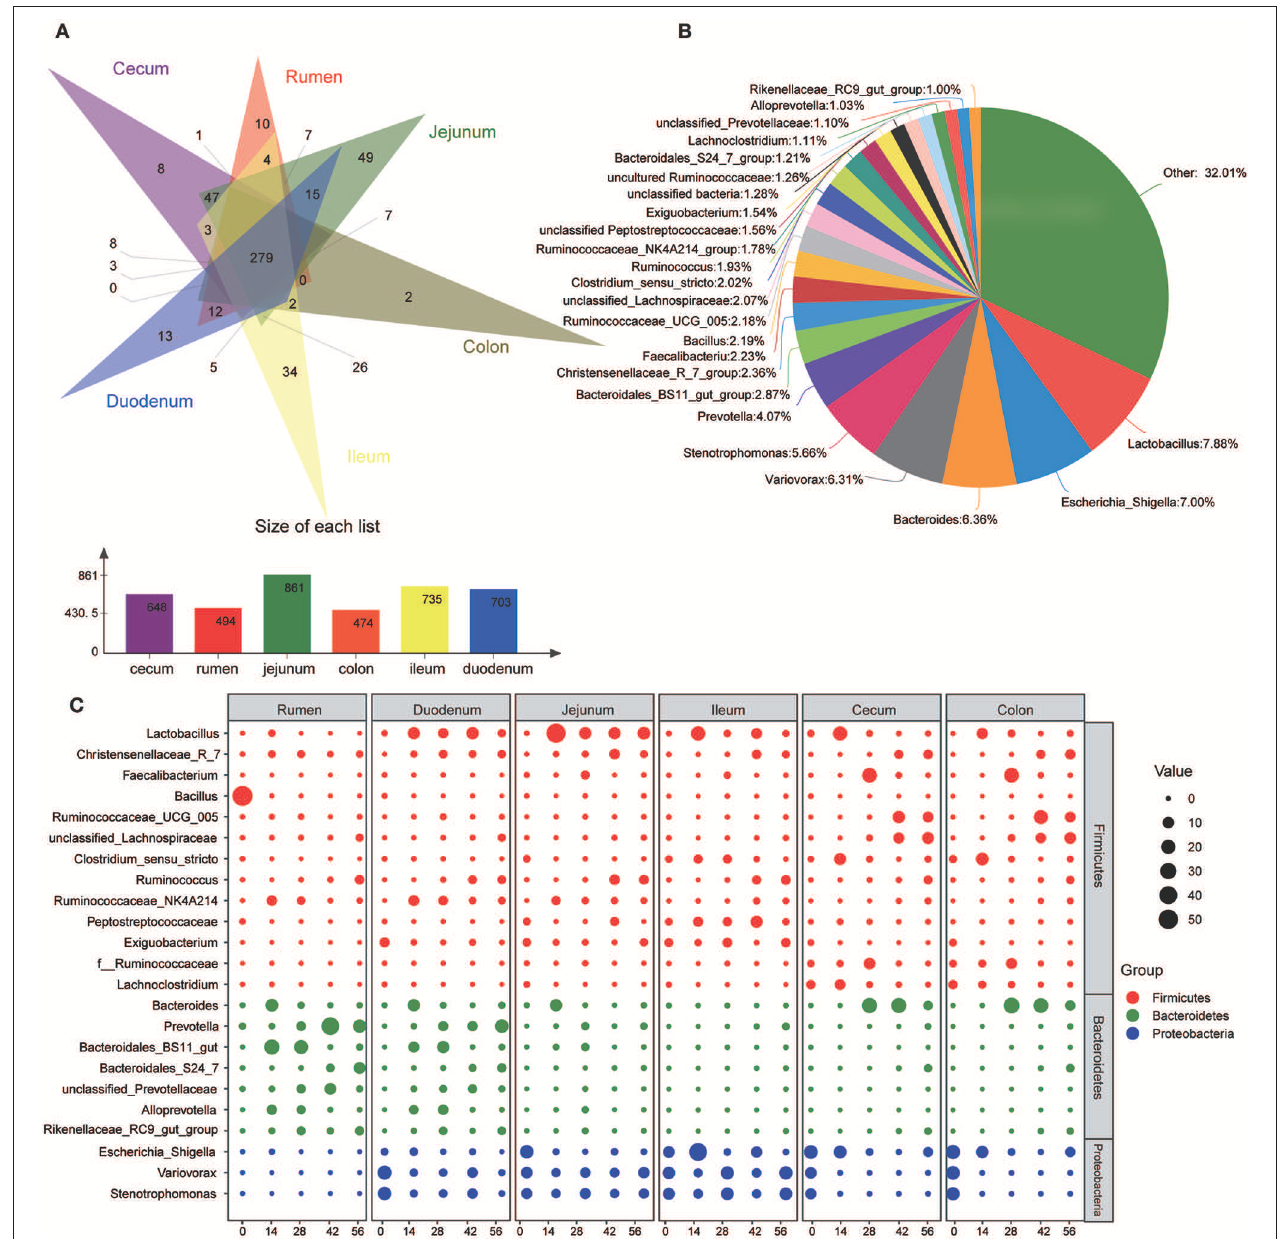
FIGURE 4 | Main common genera across the gastrointestinal tract regions. (A) Venn diagram of bacterial genera shared between rumen, duodenum, jejunum, ileum, cecum, and colon. (B) Relative proportion of predominant common genera (those with an average proportion ≥ 1% based on all common genera were selected from 279 shared genera. (C) Changes of 23 common dominant genera as kids aged in each GIT region. The red, green, and blue dots represent genera that belong to the phyla Firmicutes, Bacteroidetes, and Proteobacteria, respectively. The size of the dot represents the relative abundance of